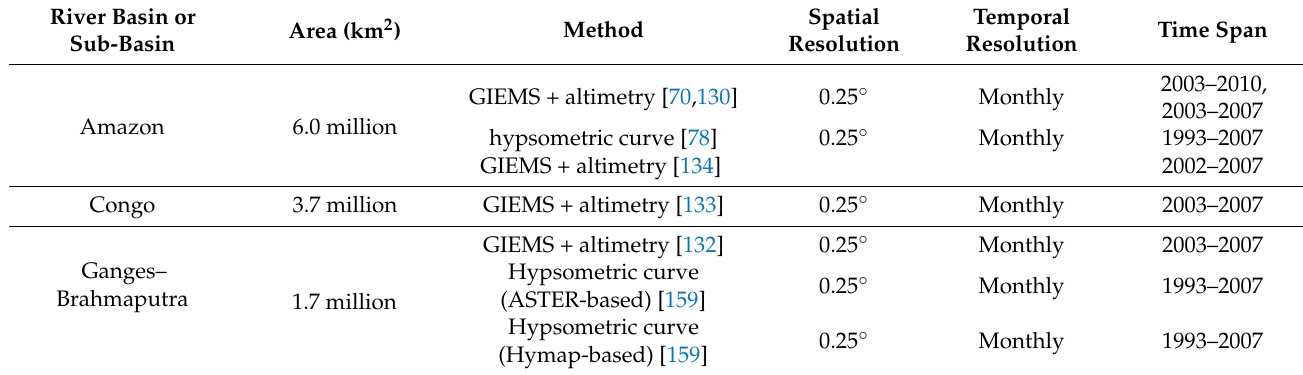
Figure 3. Examples of hypsometric curves from Multi-Error-Removed Improved-Terrain (MERIT) DEM over the Congo river basin. Left : Map of terrain elevation from MERIT DEM within a 773 km 2 cell of Global Inundation Extent from Multi-Satellite (GIEMS). Middle : The hypsometric curves from MERIT DEM, i.e., the distribution of all elevation values in a 773 km 2 cell of Global Inundation Extent from Multi-Satellite (GIEMS) sorted in ascending order. Right : The hypsometric curves from MERIT DEM providing the relationship between surface water elevation and the inundated area of a 773 km 2 pixel (as a percentage). The blue (purple) line is the minimum (maximum) coverage of surface water observed by GIEMS during 1992–2015. Table 2. Main characteristics of the various approaches used to estimate SWS variations across studies for several large river basins. The first column is the name of the river basin. The second column is the total drainage area of the basin, and the value in brackets is the area considered for the cited study. The third column provides the method used to derive SWS along with the references of the study in brackets. The fourth and fifth columns provide the spatial and temporal resolutions of the SWS estimates. The sixth column provides the time span of the dataset.